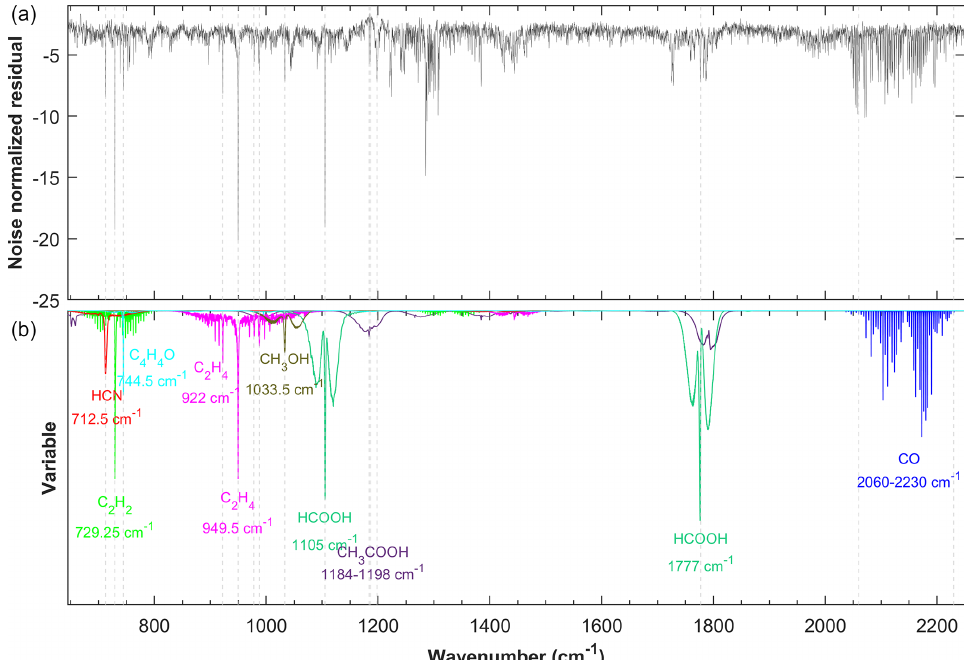
Figure 8. (a) Example of GMI pseudo-residual calculated from IASI/Metop-B L1C data during the intense fire event in Australia on 1 January 2020 in the morning (daytime or AM orbit). (b) The HITRAN spectroscopic parameters associated with the absorption (Gordon et al., 2017, 2022) of different species are shown with